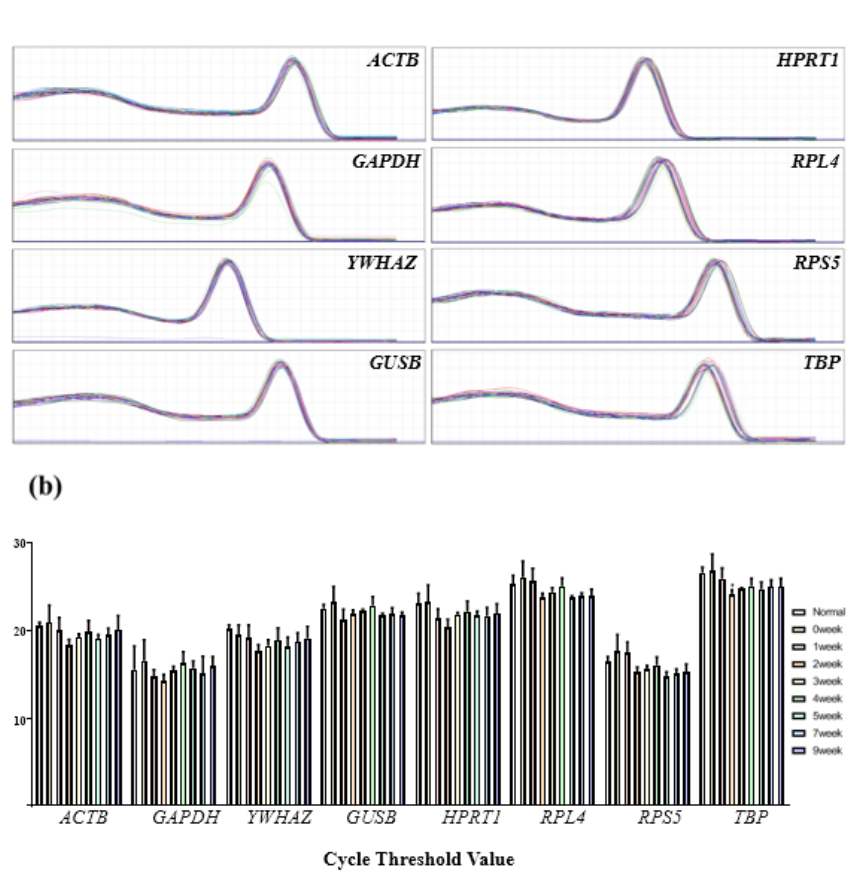
Figure 2. Examination of amplicon size, melting curve, and Ct value of candidate reference gene. ( a ) PCR amplicon product was evaluated by electrophoresis using 1% agarose gel. Melting curves and agarose gel electrophoresis were used to examine the specificity of primers and amplicon lengths of eight chosen reference genes. Electrophoresis used 1% agarose gel shown the expected product size without non ‐ specific amplification. Lanes show ladder (100 and 200 bp). During melting curve analysis, a single peak of melting curve informed with no non ‐ specific product. ( b ) The Ct value of eight reference genes in 0, 1, 2, 3, 4, 5, 7, and 9 weeks post ‐ irradiation. The data was presented as mean ± SD. p value by one ‐ way (ANOVA) analysis of variance followed BY Bonferroni post hoc test were ∗ p < 0.05.